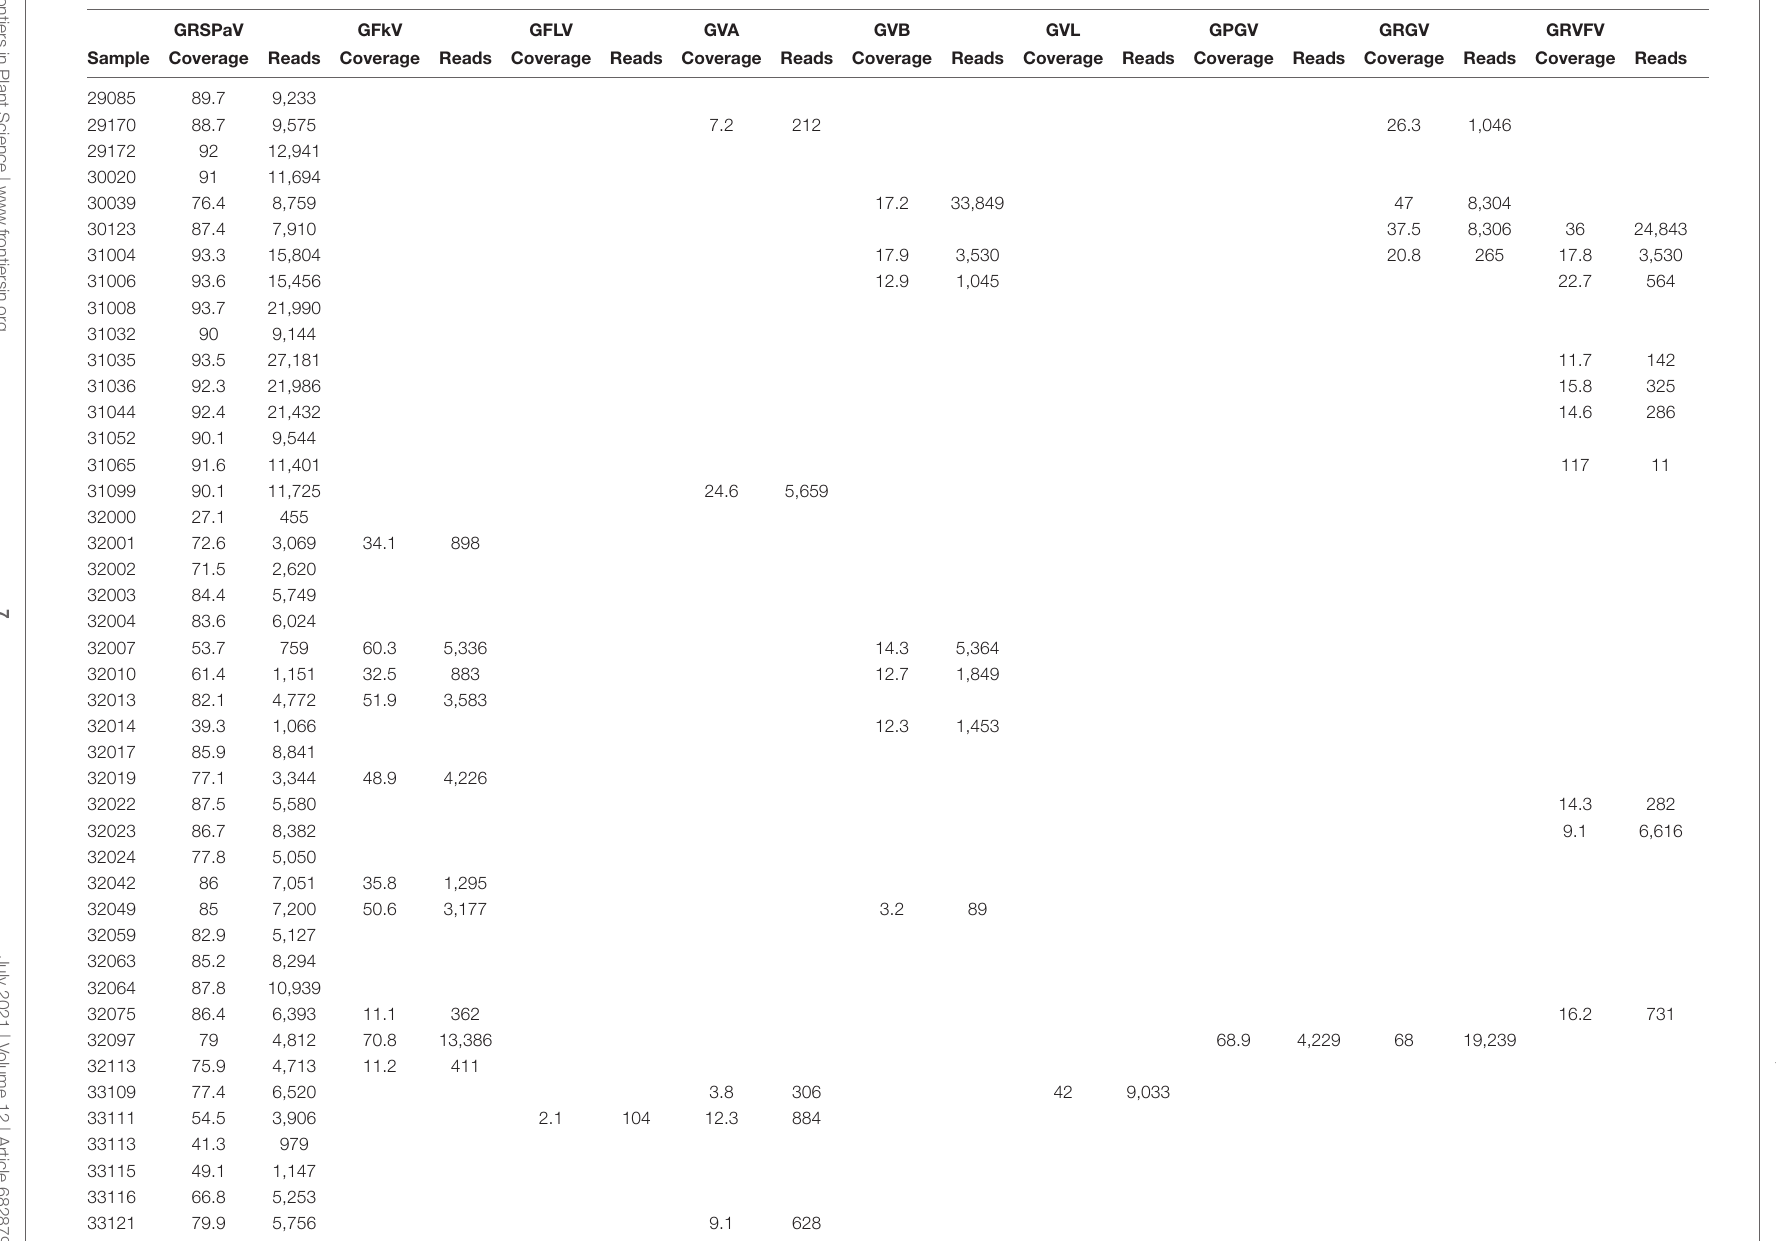
TABLE 2 | Quantitation of reads and percentage of genome coverage aligning to non-GLRD viruses identified by HTS. GRSPaV GFkV